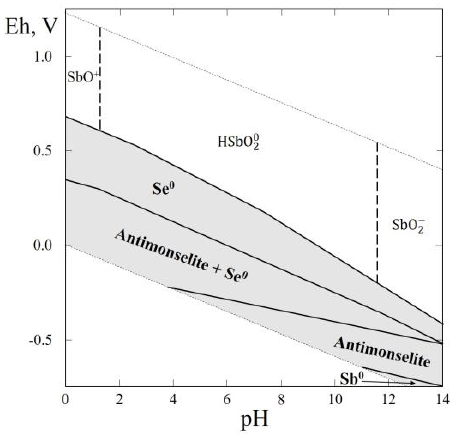
Figure 13. Eh – pH diagram of the OHSeSb (Sb-Se-H 2 O) system at 25 °C and the activities of the components: a ΣSe = 10 − 4 , a ΣSb = 10 − 5 . The dotted lines are the boundaries between fields of SbO + , HSbO 20 and SbO 2 .